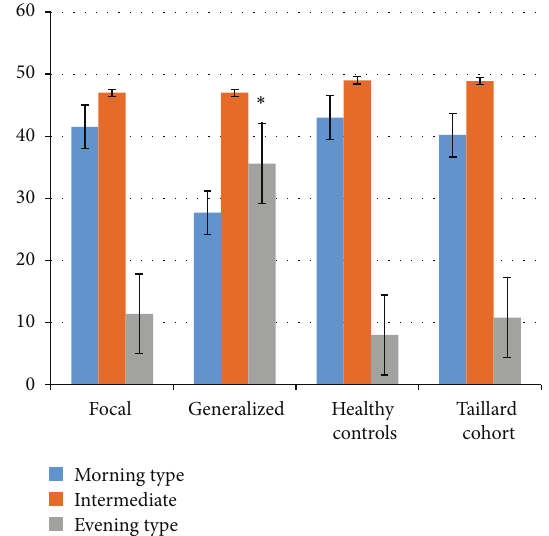
Figure 1: Distribution of different chronotypes among patients with generalized epilepsy, patients with focal epilepsy, healthy controls, and historic controls. The 𝑌 -axis indicated the percent of subjects in each chronotype as designated by the colored bar. ∗ 𝑝 < 0.01